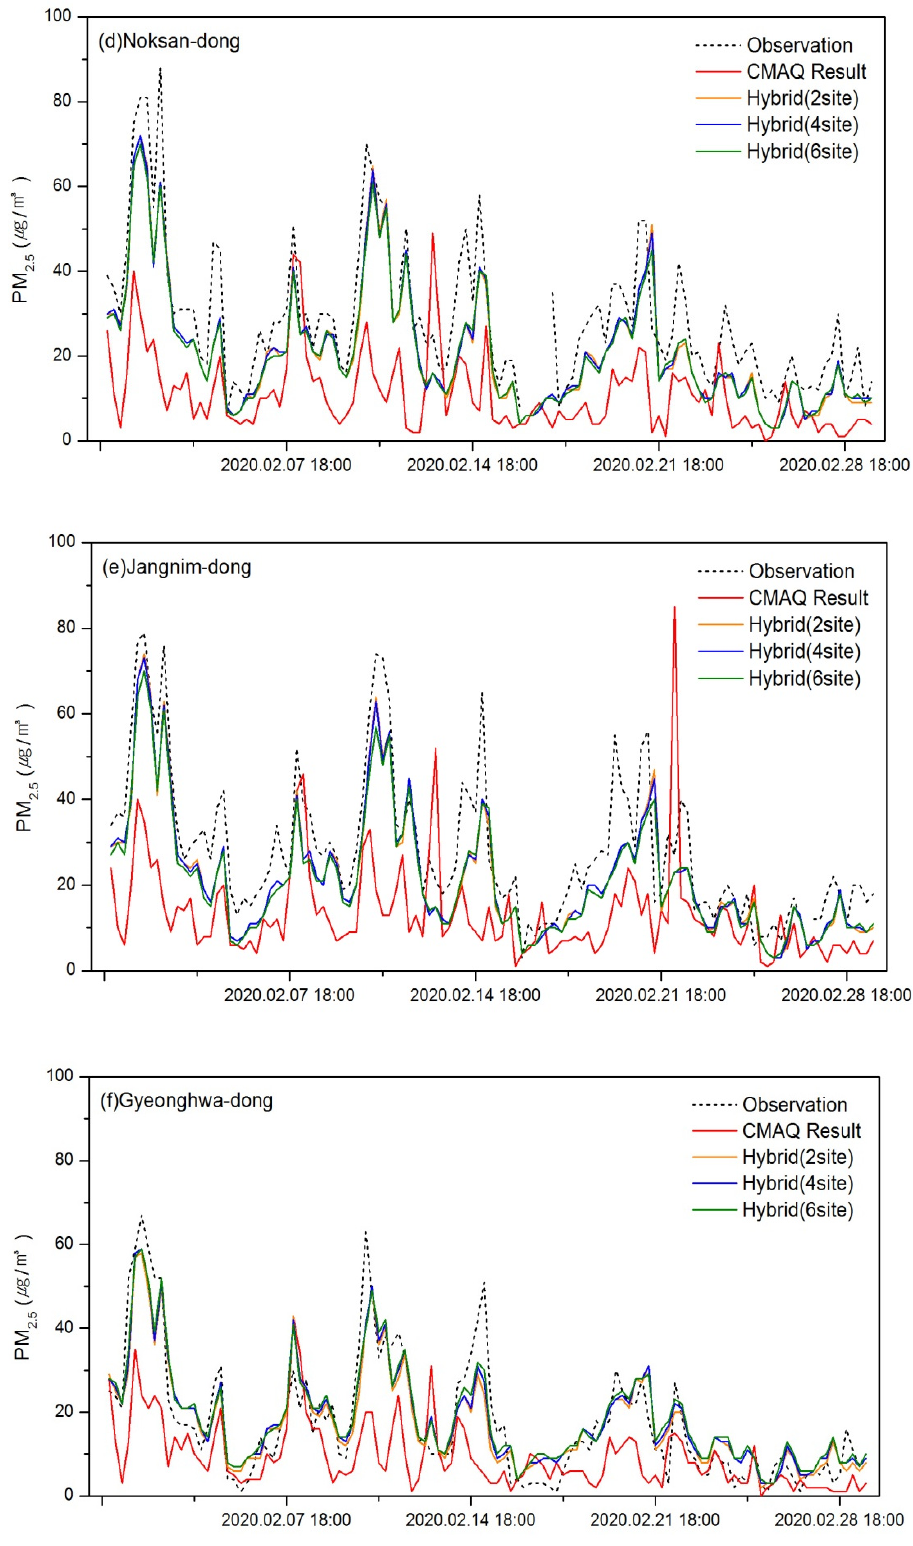
Figure 9. Time series graph for the prediction period by verification points. ( a ) Choryang-dong, ( b ) Gwangbok-dong, ( c ) Gwangan-dong, ( d ) Noksan-dong, ( e ) Jangnim-dong, ( f ) Gyeonghwa-dong